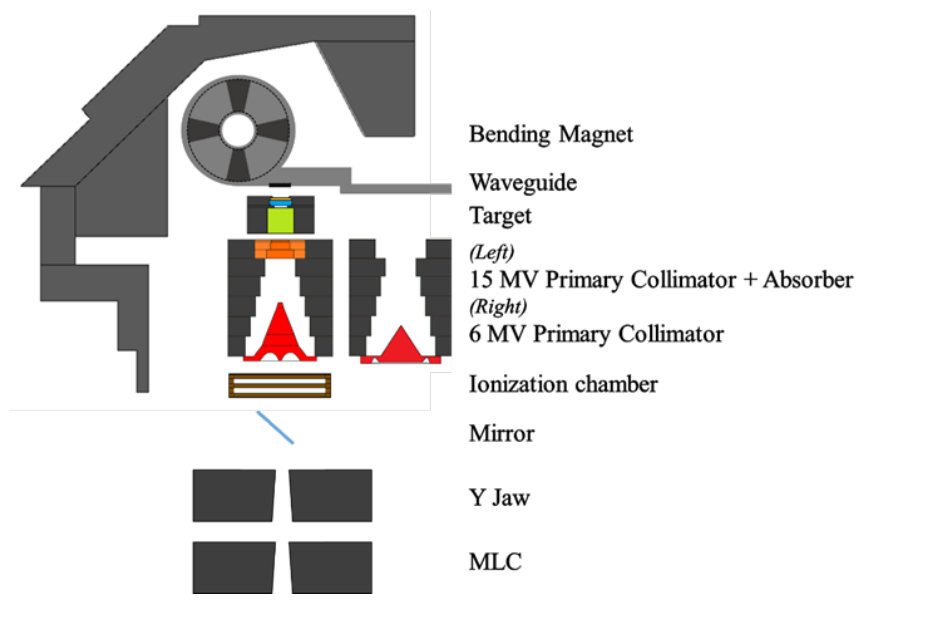
Figure 1. Components of the Siemens linac head.